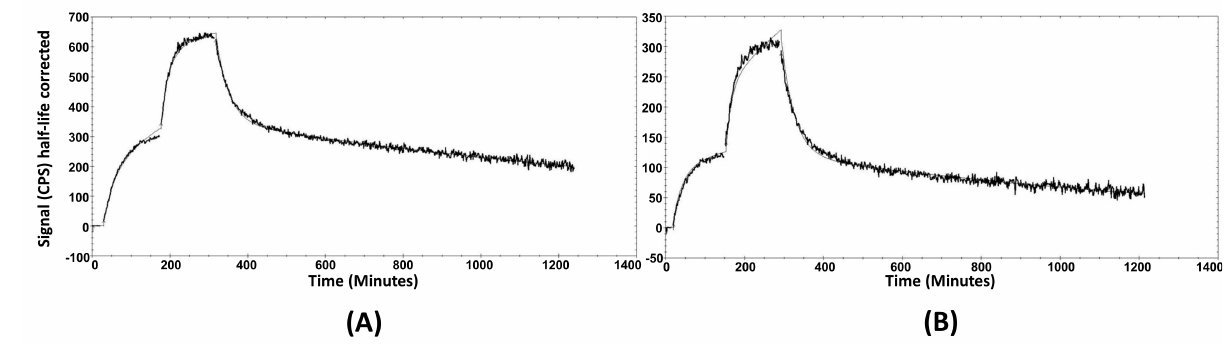
Figure 4. The sensorgrams obtained using LigandTracer Yellow for [ 99m Tc]Tc-maSSS-PEG 2 -RM26 ( A ) and [ 99m Tc]Tc-maSES- PEG 2 -RM26 ( B ). The concentrations during association measurements were 0.5 and 2 nM for each radiolabeled peptide. Table 1. Affinity measurements of [ 99m Tc]Tc-maSSS-PEG 2 -RM26 and [ 99m Tc]Tc-maSES-PEG 2 -RM26. Interaction Constants